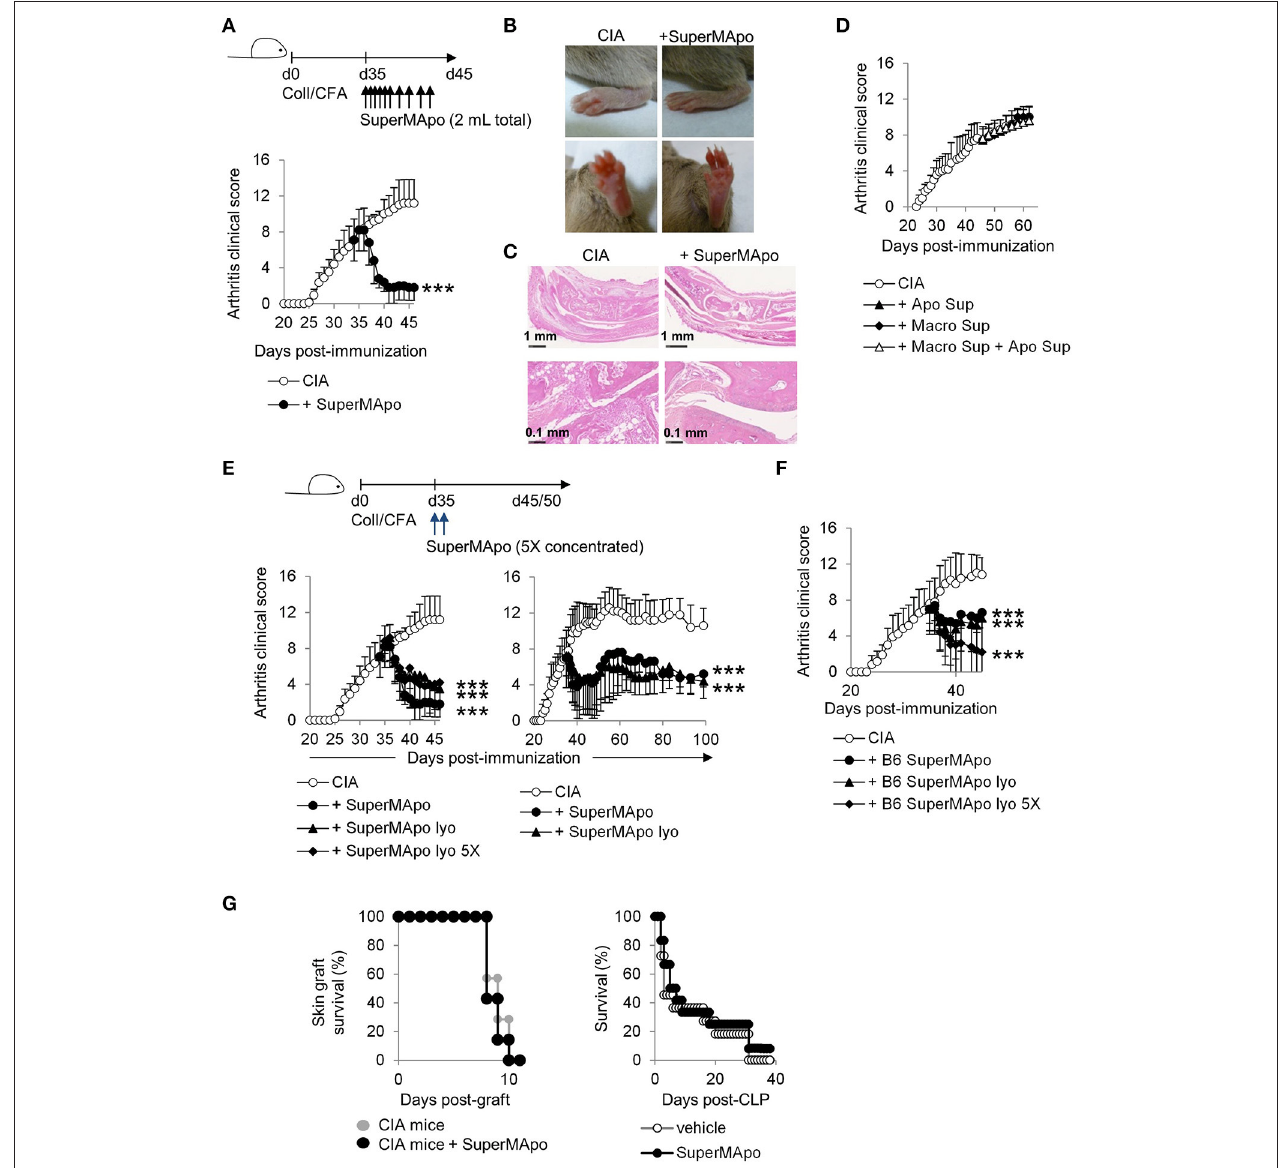
FIGURE 2 | Injection of SuperMApo in ongoing CIA induced a rapid termination of the disease. (A) The clinical arthritic score (mean ± s.e.m., n = 5 per group) after SuperMApo injections was strongly reduced in arthritic mice compared to CIA mice receiving control vehicle injections (CIA). *** P < 0.001, one-way ANOVA with Bonferroni’s multiple comparison post-tests. (B) Representative pictures of paw swelling reduction after SuperMApo injection. (C) HES staining of rear ankle joint sections showing vehicle-(CIA) and SuperMApo-treated arthritic mice conditions. (D) The clinical arthritis score (mean ± s.e.m., n = 5 per group) of mice receiving the supernatant from apoptotic cell culture, or from macrophage culture or both the previous together did not demonstrated reduction. (E,F) Arthritic mice treated with lyophilized SuperMApo concentrated (SuperMApo lyo 5X) or not (SuperMApo lyo), demonstrated arthritis clinical score reduction, lasting for more than 60 days,